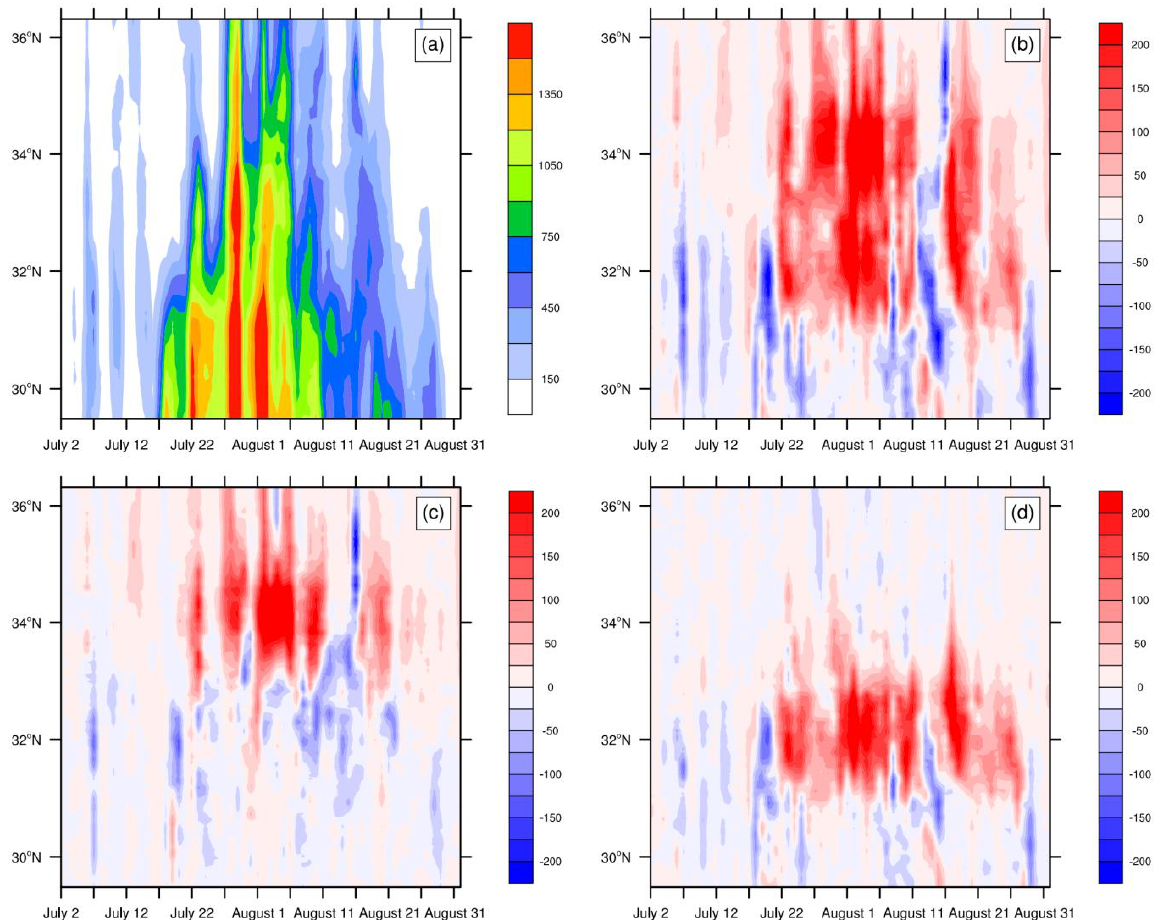
Figure 11. Time – latitude diagrams of convective available potential energy (CAPE) (J kg −1 ) averaged in domain 3 in CTRL ( a ). Panels ( b – d ) are the differences ( b ) between LowQD and CTRL (LowQD minus CTRL), ( c ) between LowQ and CTRL (LowQ minus CTRL), as well as ( d ) between LowD and CTRL (LowD minus CTRL), respectively. Blue (red) shading indicates negative (positive) variation. Here the CAPE refers to the MCAPE, which is maximum convective available potential energy.